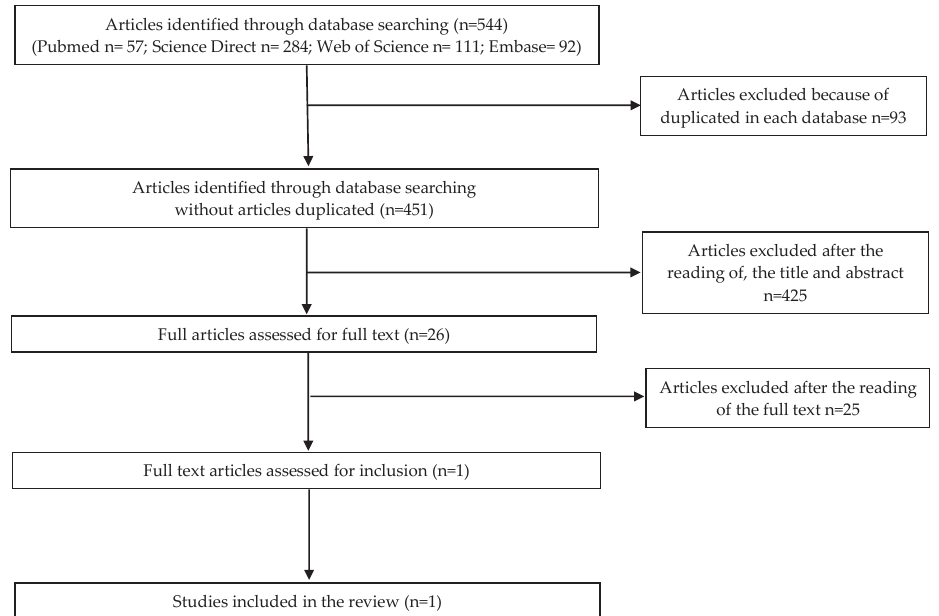
Figure 1. PRISMA (Preferred Reporting Items for Systematic reviews and Meta-Analyses) selection for microbiological risk.